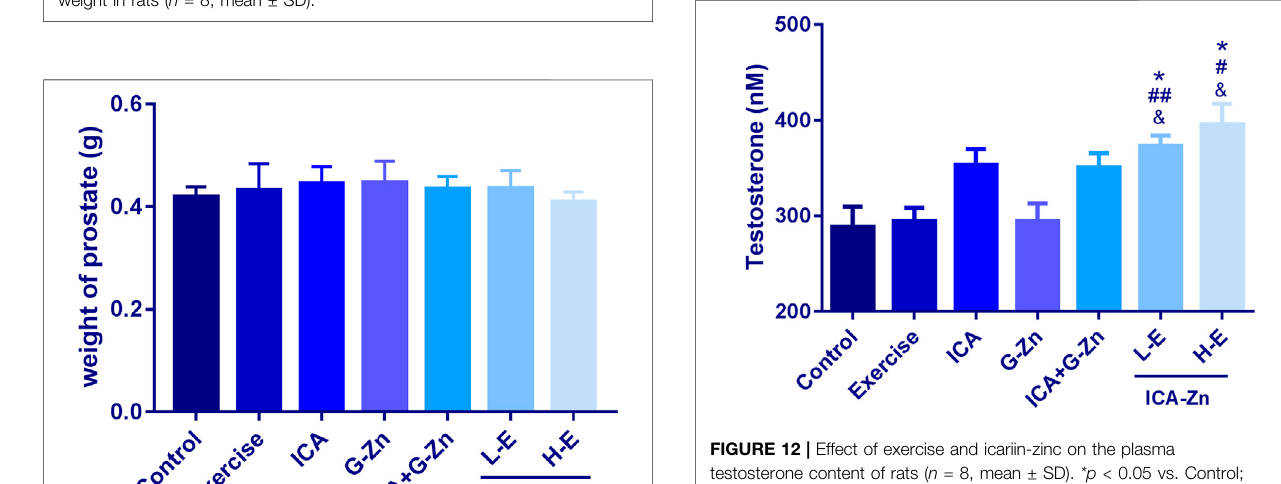
FIGURE 9 | Effect of icariin-zinc on the weight of the seminal vesicle weight in rats ( n (cid:2) 8, mean ± SD).